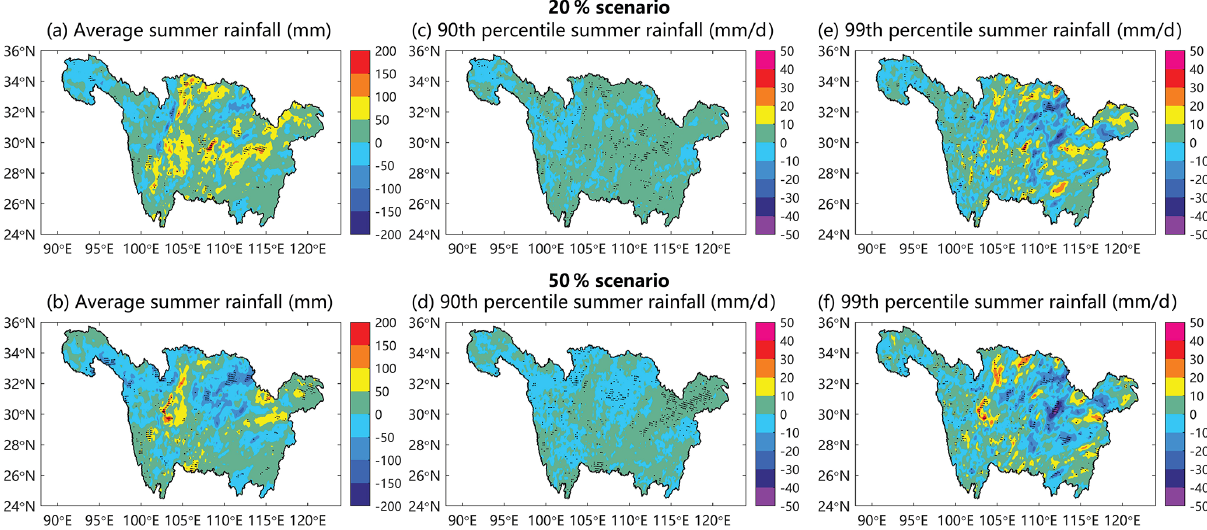
Figure 9. The changes in (a, b) average summer rainfall (mm), (c, d) 90th percentile summer rainfall (mmd − 1 ), and (e, f) 99th percentile summer rainfall (mmd − 1 ) between the 20% scenario and the 2010 scenario and between the 50% scenario and the 2010 scenario. The stippled regions show statistical significance of the changes identified by the t test at a 5% significance